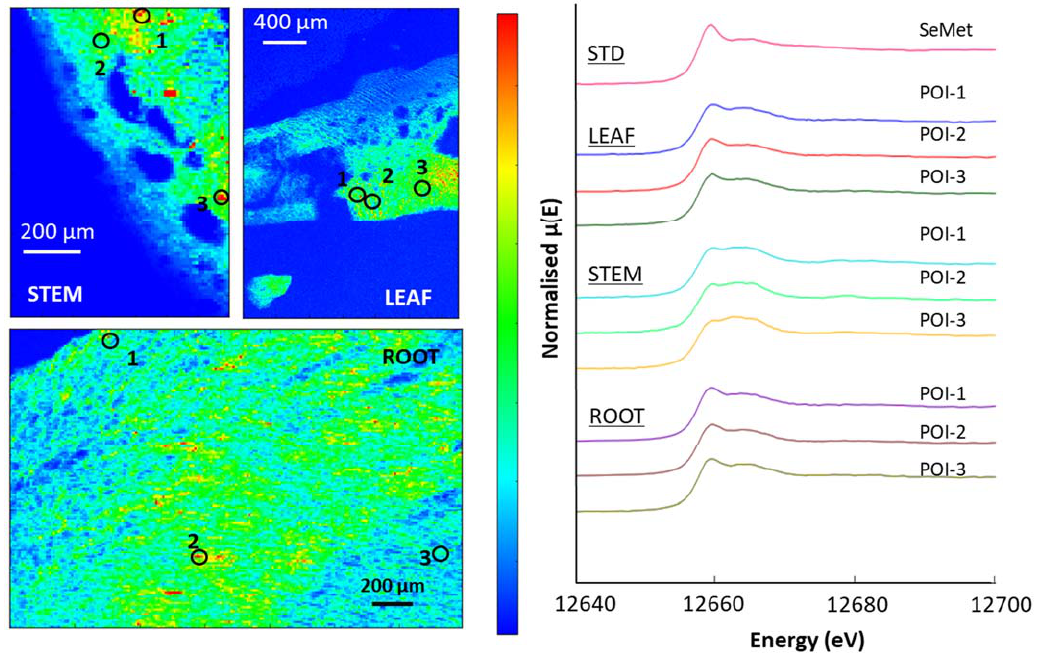
Figure A6. ( Left ): µ -XRF maps showing selenium in a cross-section of a premier kale leaf vein, stem Figure A6. Left: μ ‐ XRF maps showing selenium in a cross ‐ section of a premier kale leaf vein, stem and root, with selected points of interest (POIs) for Se K -edge XANES analysis, labelled 1–3. The and root, with selected points of interest (POIs) for Se K ‐ edge XANES analysis, labelled 1–3. The μ ‐ XRF is on a ‘pseudo ‐ temperature’ scale, with high Se counts in red and areas and no counts in dark µ -XRF is on a ‘pseudo-temperature’ scale, with high Se counts in red and areas and no counts in dark blue. Right: normalised Se K ‐ edge XANES spectra showing the selenium species in selected POIs blue. ( Right ): normalised Se K -edge XANES spectra showing the selenium species in selected POIs Soil Syst. 2023 , 7 , x FOR PEER REVIEW and the SeMet. and the SeMet.